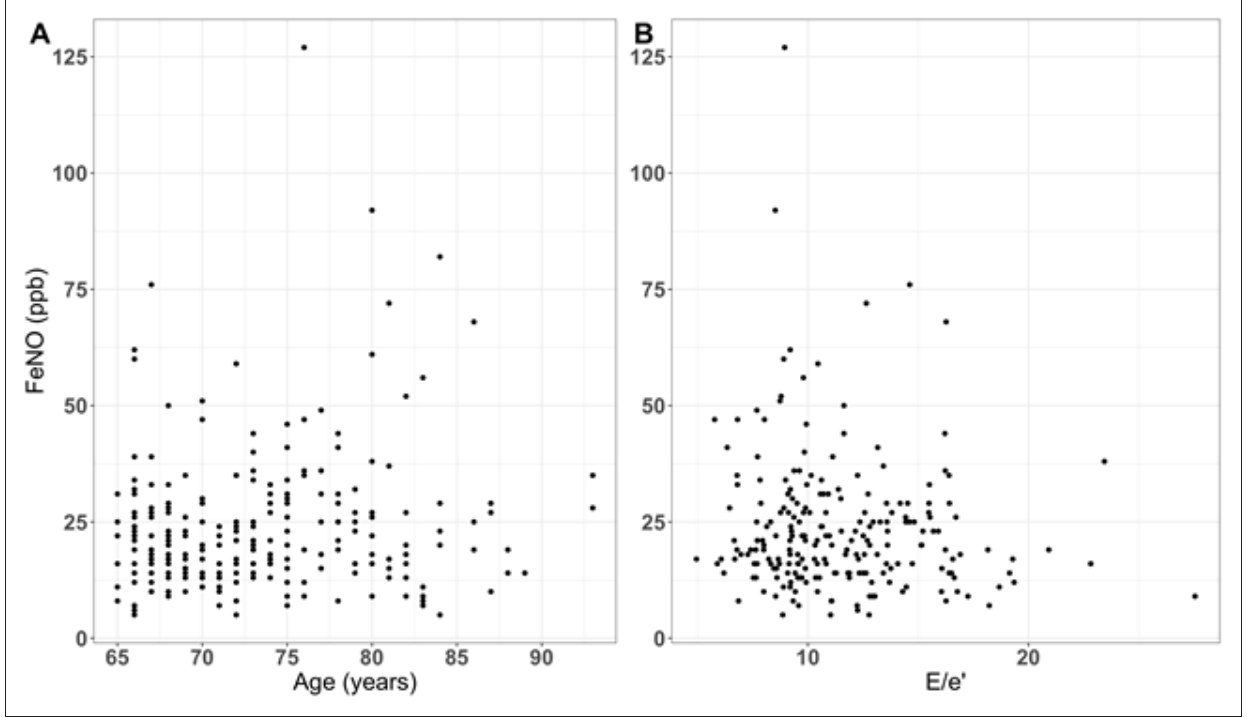
Clinical and echocardiographic characteristics of the normal, intermediate, and high E/e’ strata are displayed in Table 2 , with mean FeNO levels of 23.8±11.4, 24.1±16.1, and 22.5±13.7 ppb, respectively ( P = 0.74). Those with high E/e’ were older than those with normal E/e’ (76.8±7.4 years versus.